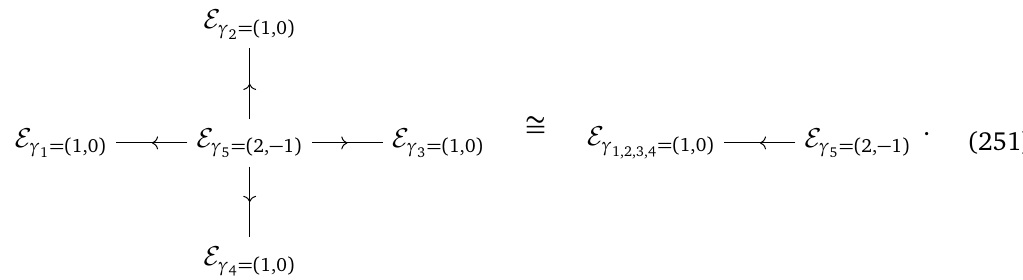
= 3 configurations. (a) Γ f ) , the massless configuration. (b) Γ ( 3 ) corresponding to the , I , I 4 1 0 1 , I , I I ) , involving the H AD point. (c) Fundamental domain for 3 0 1 ) involving the H , IV , I AD point. This last configuration 1 2 1